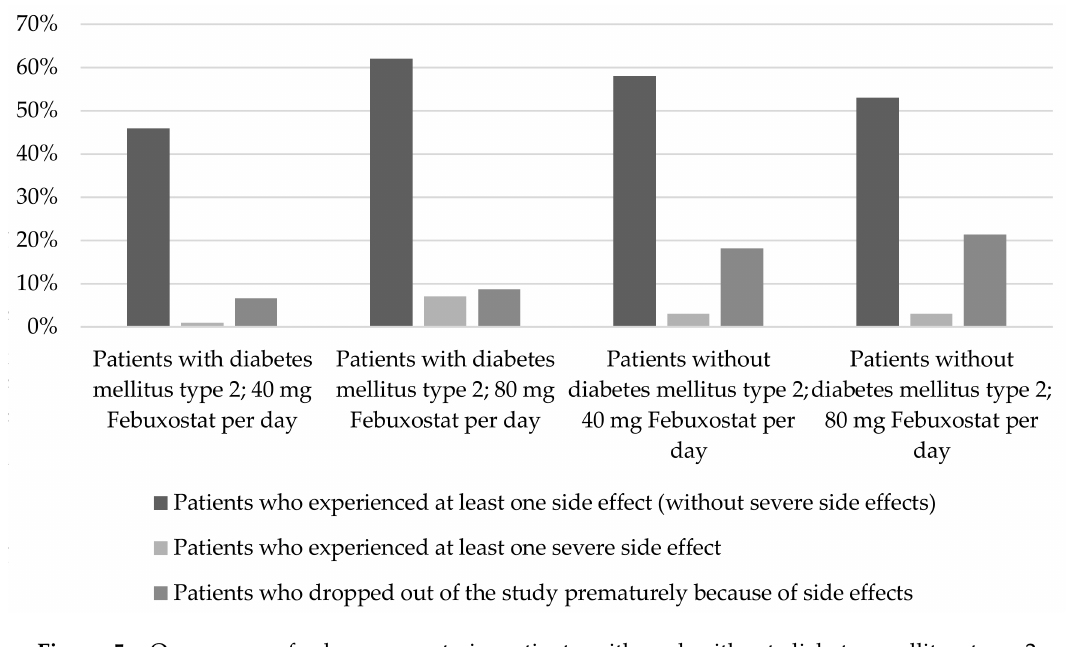
Figure 5. Occurrence of adverse events in patients with and without diabetes mellitus type 2 (n (Study population) = 1462; classification of patients by patients with and without diabetes mellitus type 2 as well as respective febuxostat dose (40 or 80 mg/day); in each case, illustration of patients who experienced at least one side effect (column 1), patients who experienced at least one severe side effect (column 2), patients who dropped out of the study prematurely (column 3))